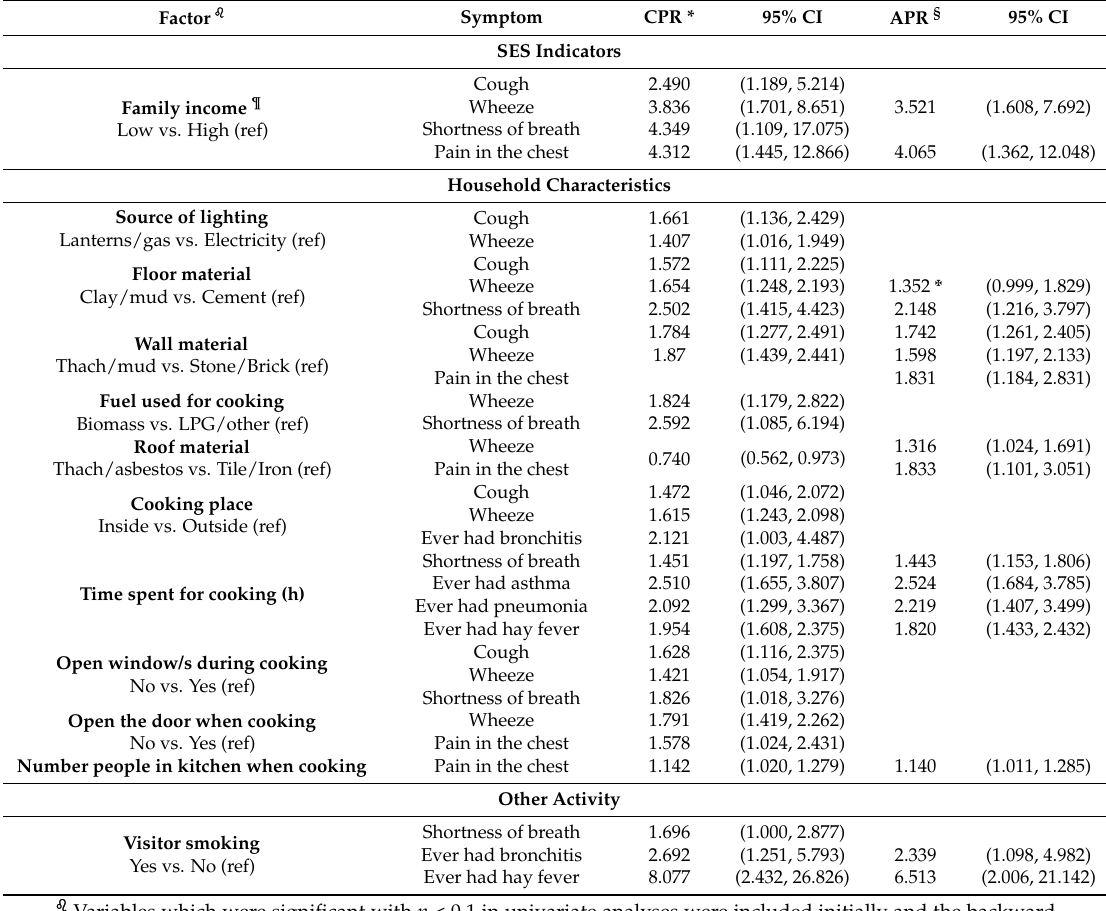
Table 4. Association between socioeconomic status, household characteristics, occupant activities, and prevalence of respiratory symptoms among mothers.